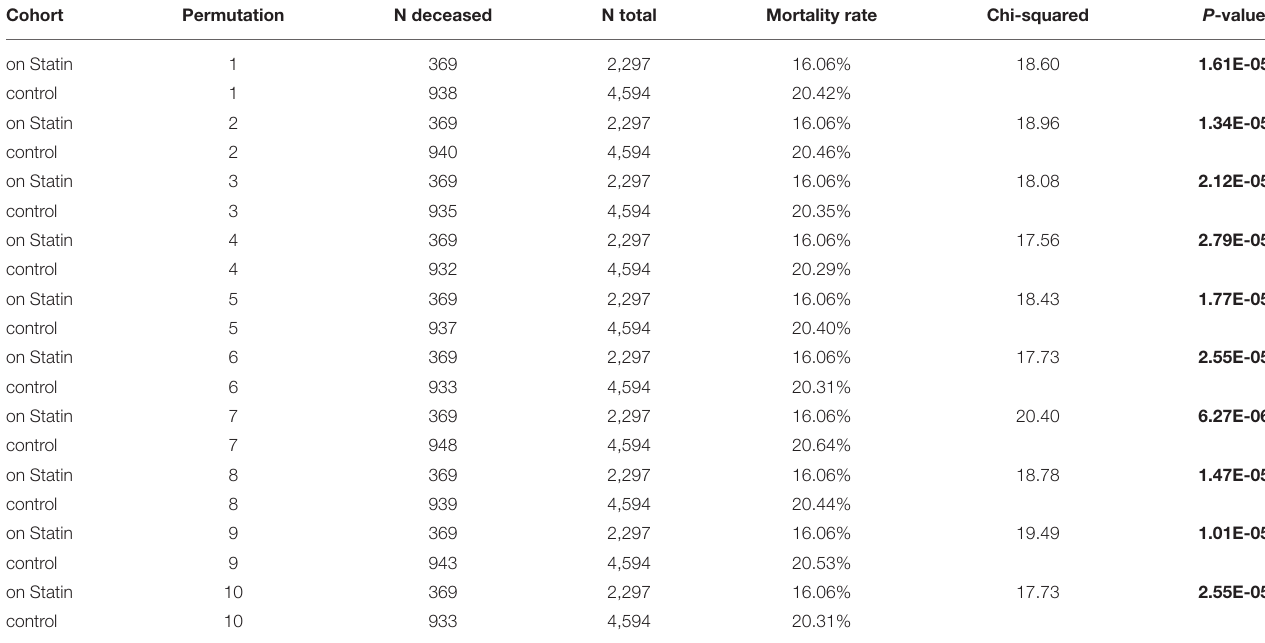
TABLE 4 | Propensity score matching by demographics, comorbidities and indication for a statin prescription: a mortality rate, associated X-squared and p -value in each iteration. Cohort Permutation Mortality